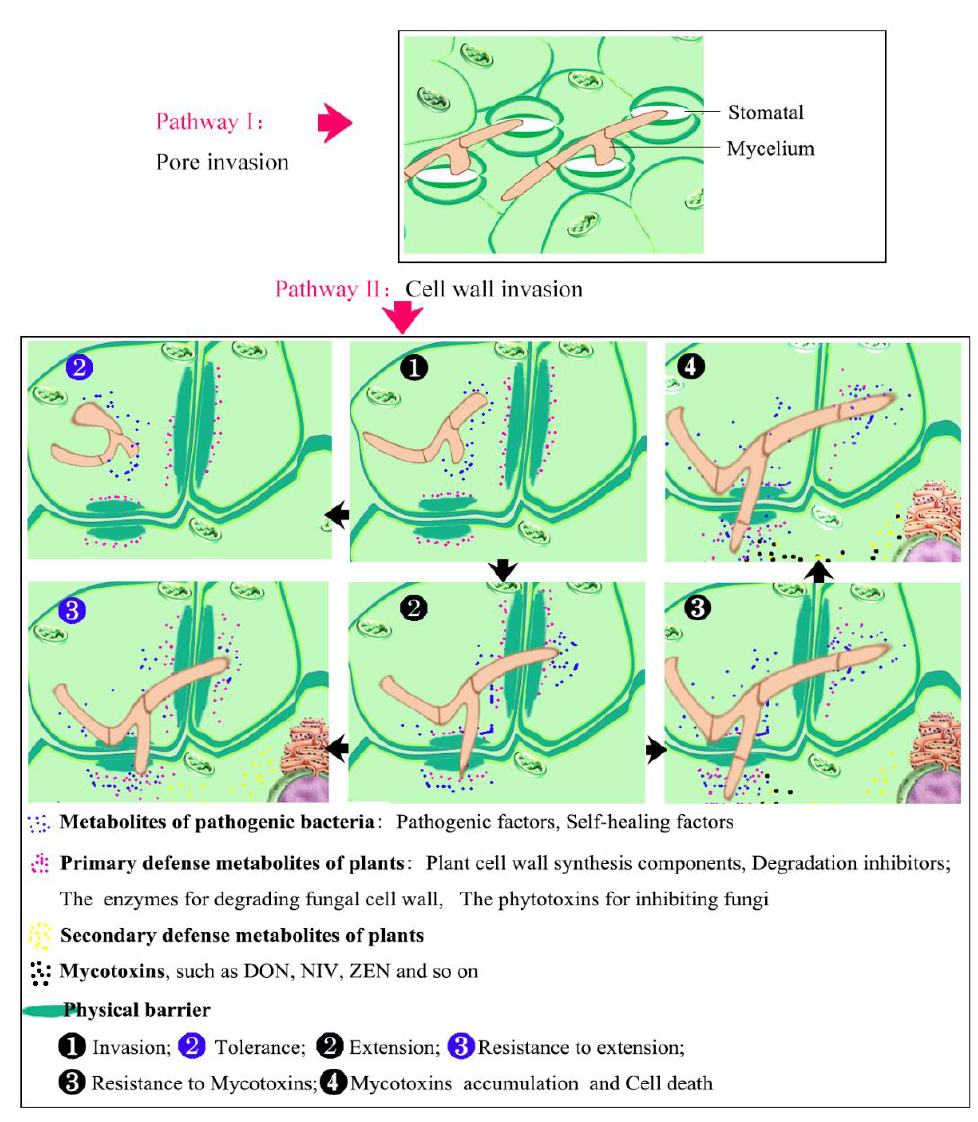
Figure 1. Model of the war between host and FHB-related pathogen. There are two ways of infecting plants with FHB-related pathogen. Pathway I: Pore invasion, in which the mycelium invades the plant directly through the natural pores present in the plant, such as stomata, the opening of the apical floret, and the gap between the palea and the outer glume. Pathway II: Cell wall invasion, where the pathogenic mycelium invades the plant directly or expands within the cells by destroying and degrading the cell surface cuticle and the cell wall. ❶ The fungus hydrolyzes the plant cuticle by synthesizing some hydrolytic enzymes (e.g., keratinase) and repairs its own cell membrane and cell wall by synthesizing chitin synthase, sphingolipids, and glucosylceramide synthase to counteract the defensive damage from the plant, while the plant reinforces the physical barrier formed by the cuticle and cell wall by synthesizing lignin, wax lipids, and pectin. Meanwhile, the plant also synthesizes chitinases, tylopectinase, and glucanase to degrade the fungal cell wall and synthesizes thionins, non-specific lipid transfer proteins, puroindolines, and ROS to disrupt and damage the fungal membrane integrity, finally counteracting the fungal invasion. ❷ The plant has stronger resistance, and the physical barrier can prevent the expansion of the pathogenic mycelium and shows a state of tolerance to the invading pathogen. ❷ The pathogenic mycelium breaks through the physical barrier of the plant and infests the adjacent cells. At this point, the plant will secrete some phytotoxins (e.g., isohydroxamate phenols) and/or synthesize phenols and bacteriostatic proteins to further inhibit the growth of the mycelium and synthesize polygalacturonase and xylanase to inhibit the degradation of its own cell wall. The pathogen further synthesizes pectinases, hemi- cellulases, cellulases, lipases, and nucleases to damage plant cell membranes and cell walls. ❸ The invasion of the pathogen promotes the expression of some resistance proteins from the plant to inhibit the development of the mycelium and the production of toxins, and the plant behaves as a